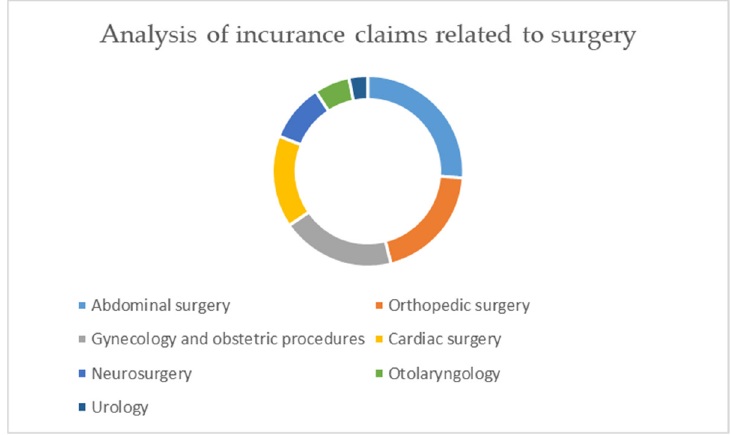
Figure 4. Analysis of insurance claims related to surgery. A total of 138 adverse events were reported during the post-operative period: 118 cases the ward